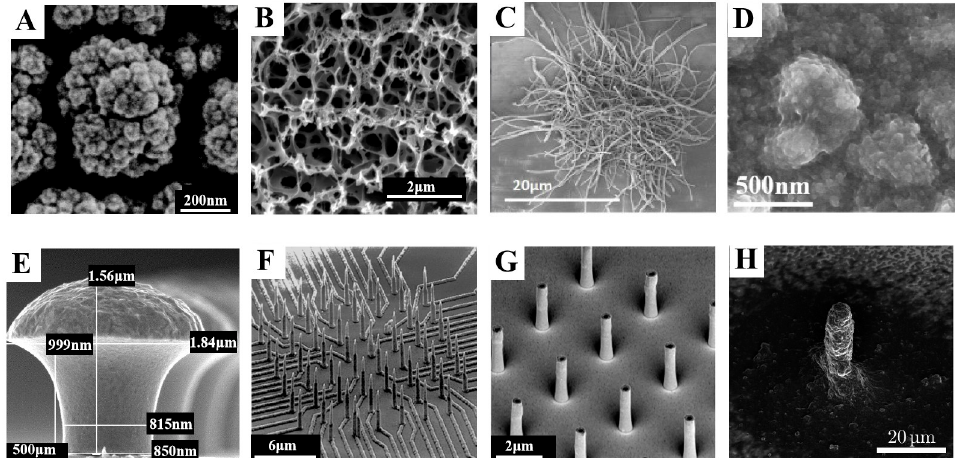
Figure 2. Methods for improving, recording, and stimulating properties of microelectrodes. ( A ) SEM diagram of platinum black [32]. Reproduced with permission from Xu, Microsystems & Nanoengi-